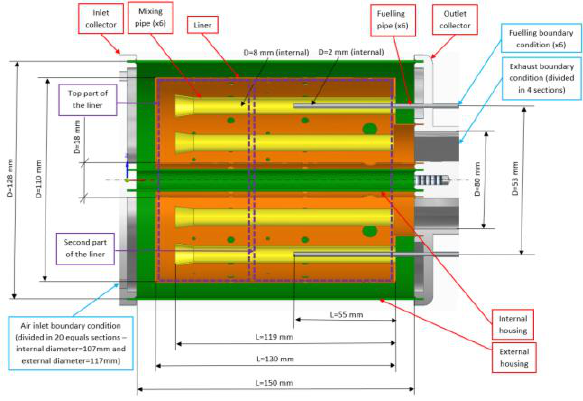
Fig. 2. The scheme of the referential combustor in 3D model Investigation of the IFGR system applied to the gas mi- modified referential combustor.